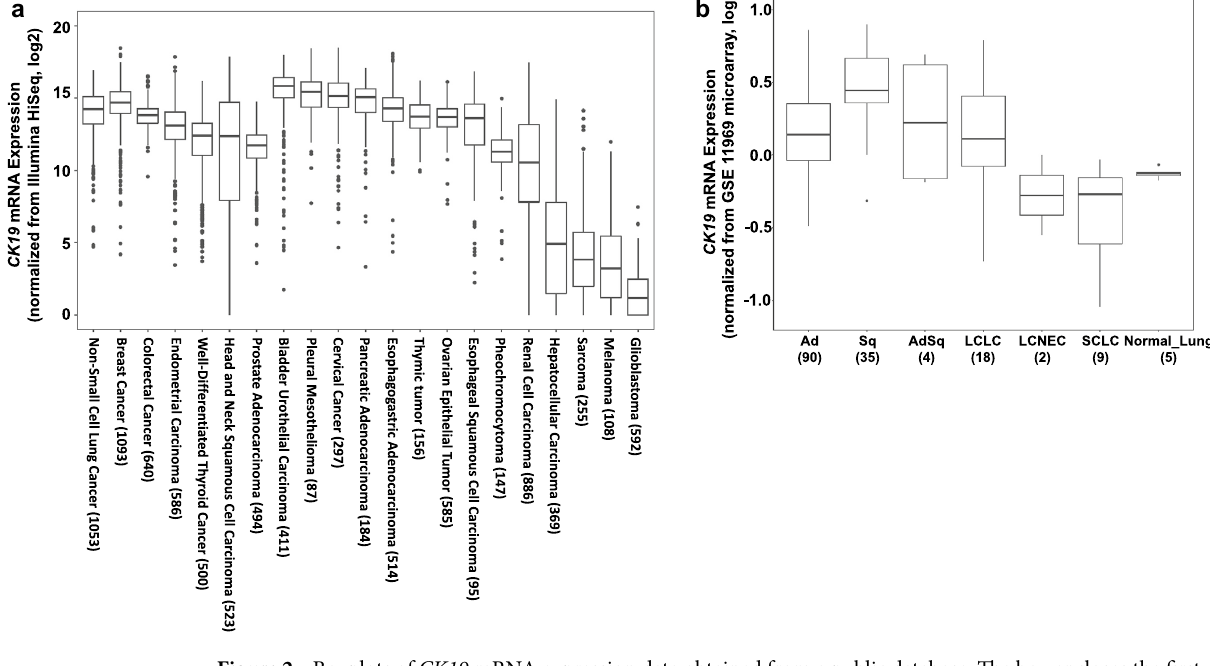
Figure 2. Boxplots of CK19 mRNA expression data obtained from a public database. The box encloses the first to third quartiles, the bar inside the box represents the median, the whisker at the top indicates the maximum value excluding outliers, and the whisker at the bottom indicates the minimum value excluding outliers. ( a ) CK19 mRNA expression data obtained from cBioPortal for patients with cancers of various types. The number of samples is shown in parentheses. ( b ) CK19 mRNA expression microarray data obtained from GSE11969 for patients with lung cancers of various histological types. The number of samples is shown in